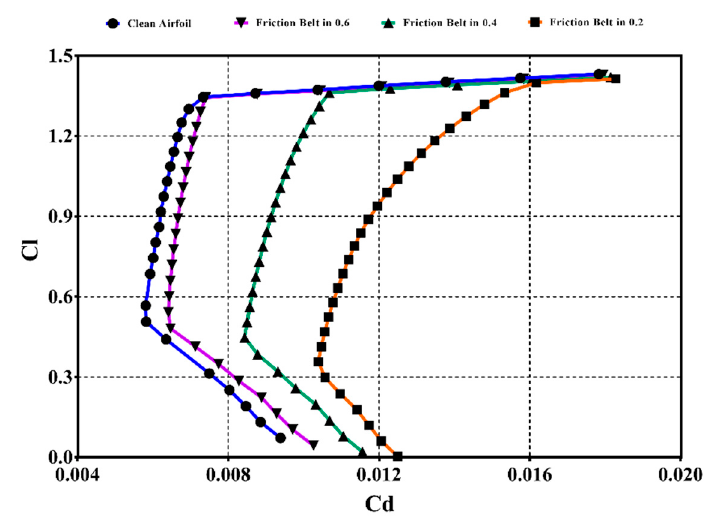
Figure 8. Aerodynamic performance of NLF-1015 under different roughness bands.